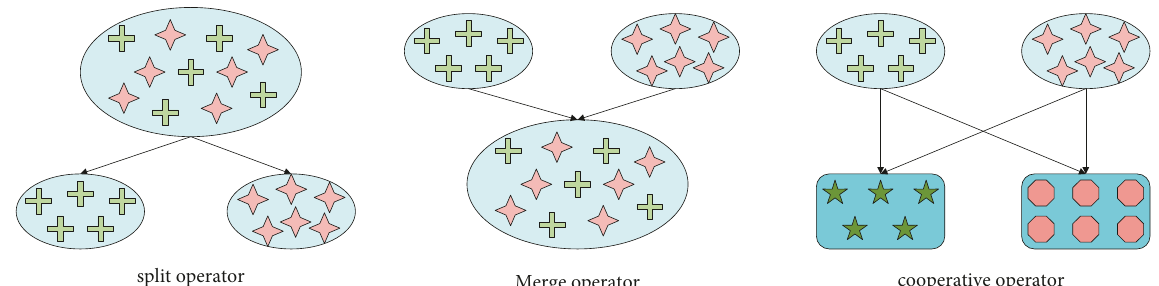
Figure 5: Organization evolution